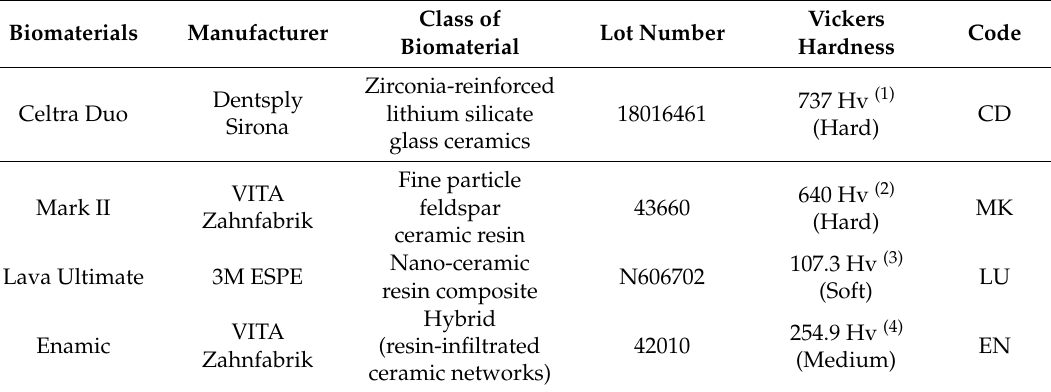
Table 1. Biomaterials used in the study.